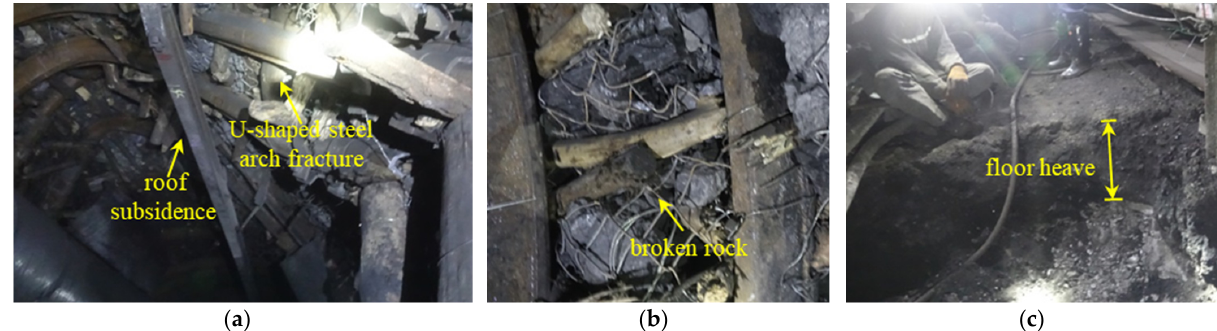
Figure 3. Failure characteristics in the 151509 tailentry. ( a ) Roof subsidence, ( b ) broken rock falling, and ( c ) floor heave.